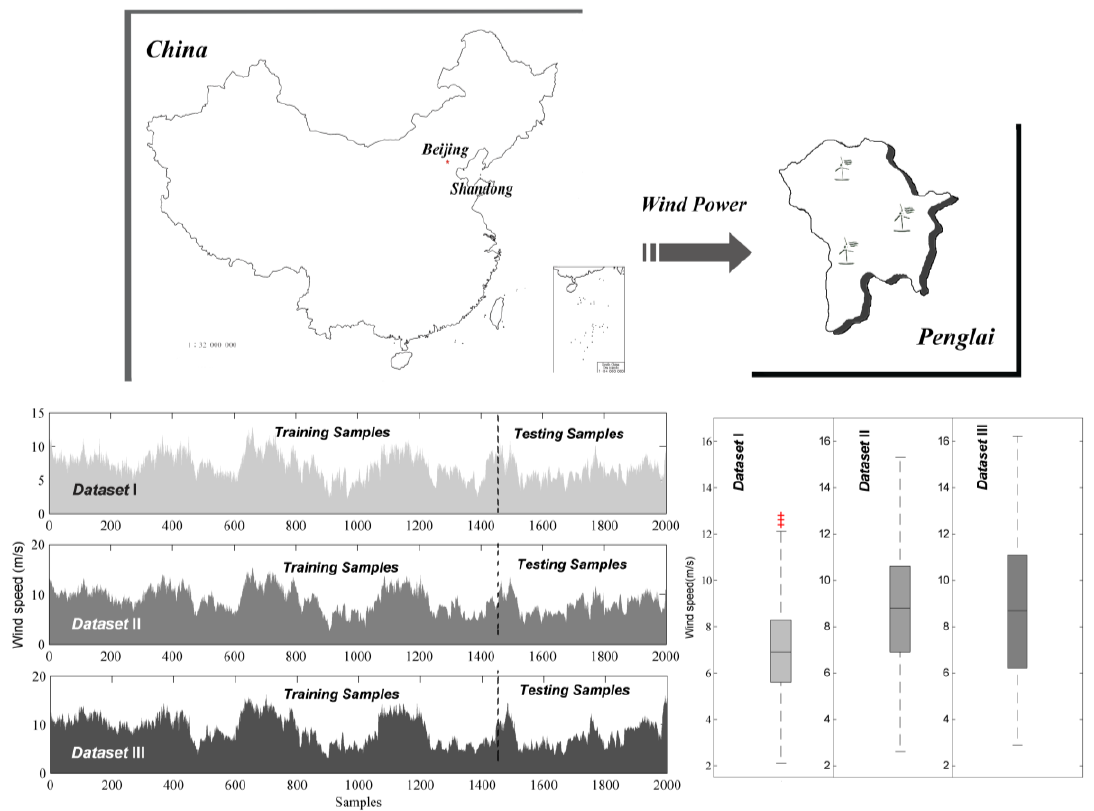
Figure 2. Data description of study sites in Penglai, Shandong Province of China.